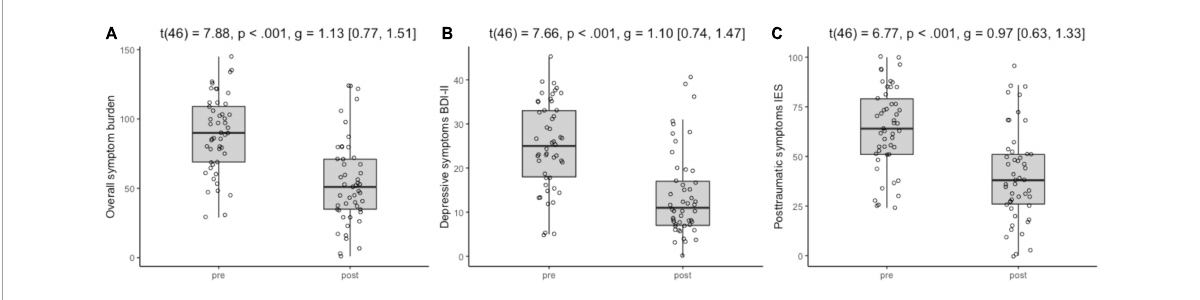
FIGURE3 Symptom change from pre- to post Eye Movement Desensitization and Reprocessing (EMDR) treatment. (A) Overall symptom burden, (B) depressive symptoms BDI-II, (C) posttraumatic symptoms IES.